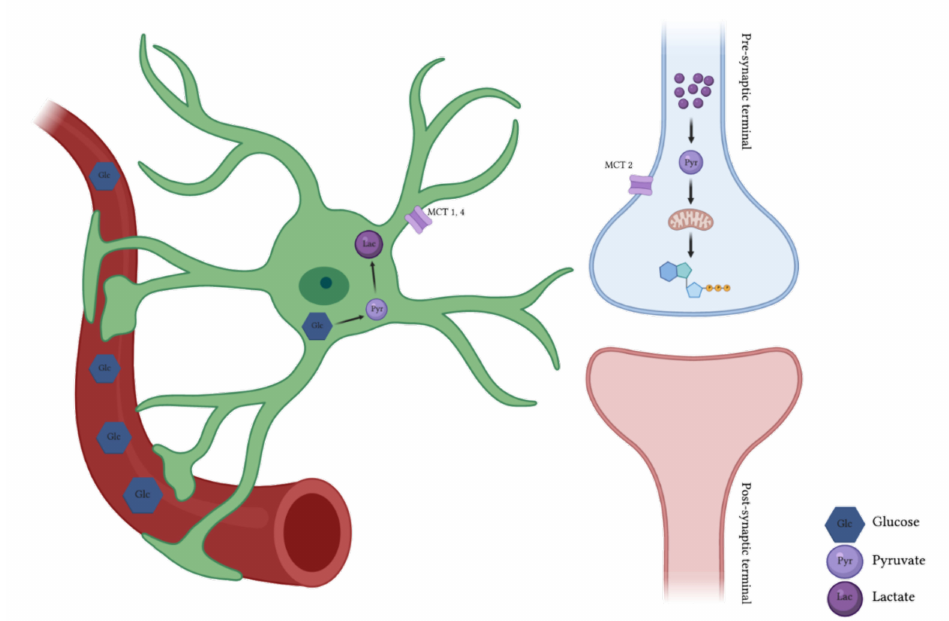
Figure 1. Representation of the astrocyte–neuron lactate shuttle which establishes that in response to glutamate-mediated neuronal activity, astrocytes take up glucose and process it through aerobic glycolysis resulting in lactate formation. Lactate can also be formed through the breakdown of glycogen by increased extracellular K + levels associated with increased neuronal activity or by the activation of noradrenaline and b2 adrenergic receptors [1,17]. Lactate is consequently shuttled from astrocytes via MCT1,4 and taken up by neurons via MCT2 to fuel their tricarboxylic acid cycle. Astrocytes possess the necessary enzymatic machinery for glycogen breakdown and conversion to pyruvate/lactate, which is consequently shuttled to neurons to fuel their tricarboxylic acid (TCA) cycle [3,11]. The metabolism of glucose via glycogen, also known as glycogen shunt activity, has been demonstrated to operate in exercising muscle, as well as in the brain [18,19]. This model establishes that glial glucose flux is divided